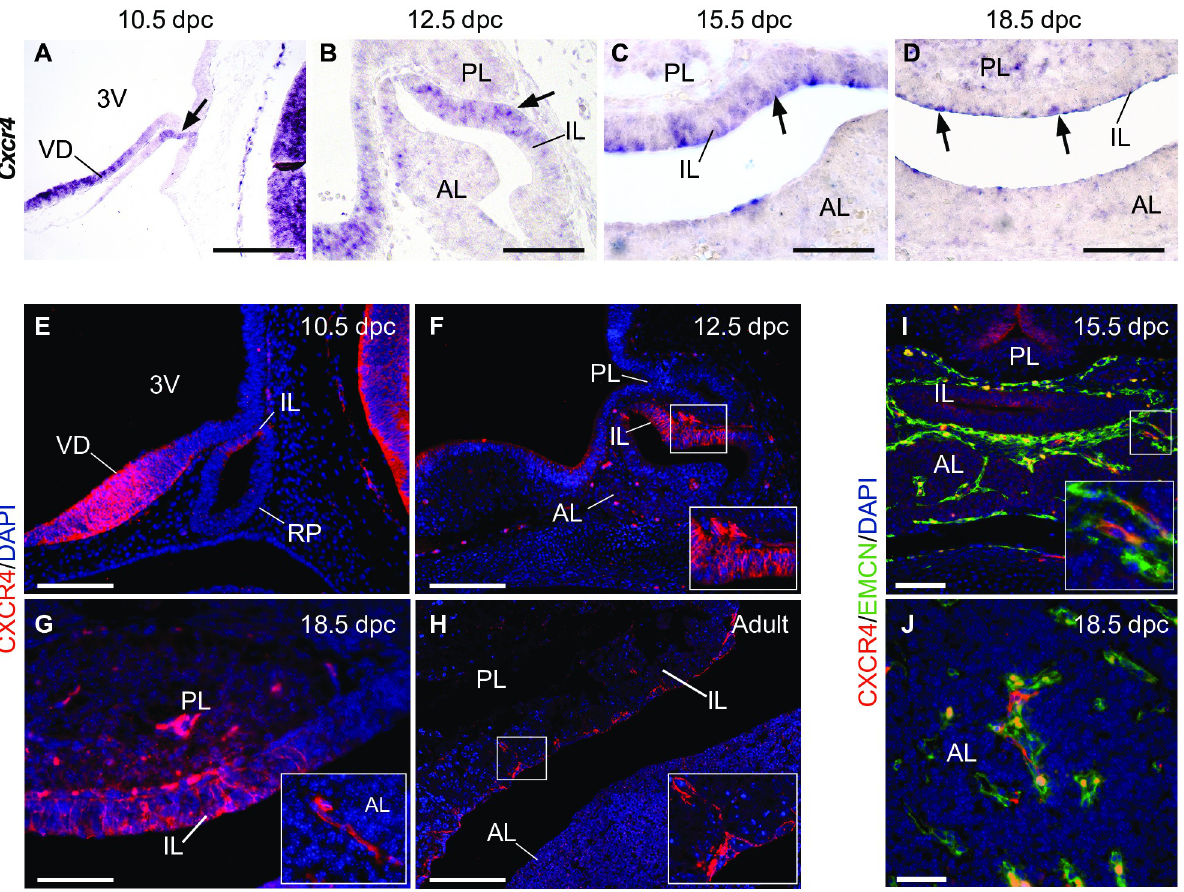
Fig 1. The expression pattern of CXCR4 mRNA and protein at different stages of murine pituitary development. (A-D) In situ hybridisation (ISH) at 10.5, 12.5, 15.5 and 18.5 dpc shows expression of CXCR4 mRNA in prospective intermediate lobe (IL) of the developing pituitary (arrows). Diffuse positive cells can also be observed in the posterior and anterior lobes (PL and AL, respectively). (E-G) Immunofluorescent staining against CXCR4 protein confirms the ISH expression pattern throughout development. Inset in F: Positive cells are also observed in the boundary between the IL and PL at 12.5 dpc. Inset in G: CXCR4+ cells with elongated morphology are observed in the AL at 18.5 dpc. (H) The IL of adult pituitaries contain CXCR4+ cells lining the pituitary lumen (inset), while a diffuse pattern of CXCR4 expression is observed throughout the AL. (I-J) Double immunostaining at 15.5 dpc and 18.5 dpc for the endothelial marker Endomucin (EMCN) and CXCR4 shows CXCR4+ cells are closely associated to the developing AL vasculature. Counterstain is DAPI. Scale bars: A-F: 200 μ m; G-I: 100 μ m; J: 50 μ m. 3V: Third ventricle; VD: Ventral diencephalon; IL; Intermediate lobe; RP: Rathke’s Pouch; AL: Anterior Lobe; PL: Posterior Lobe.